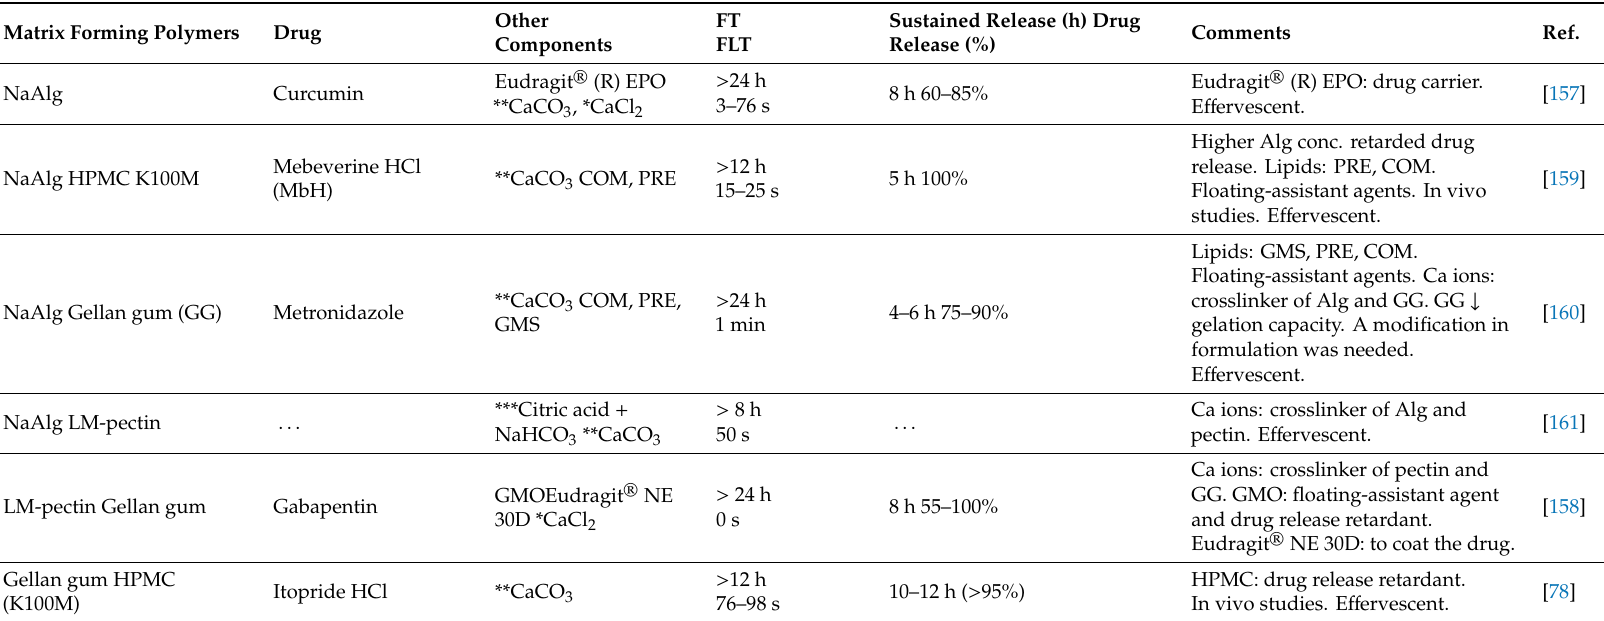
Table 9. Selected examples of raft systems prepared by ionotropic